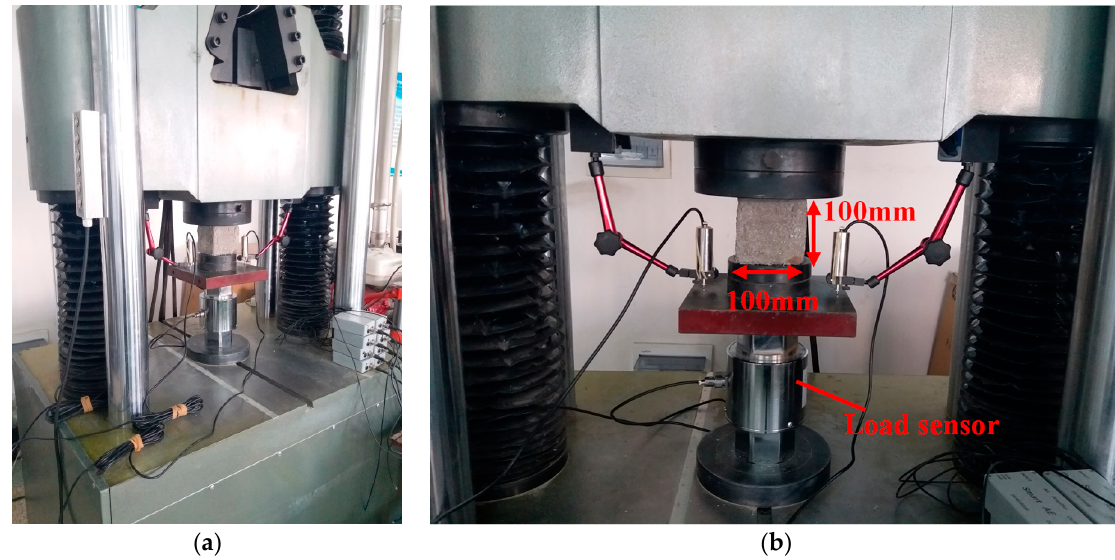
Figure 4. Schematic diagram for compression test of cubic specimen. ( a ) WAW–2000 kN test machine, ( b ) Test setup for cubic compressive strength.